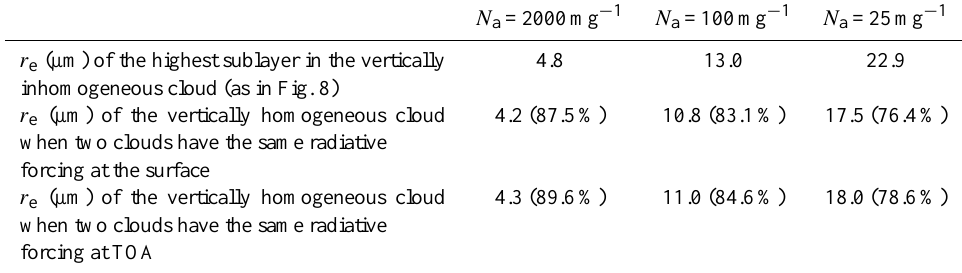
Table 1. Comparison of the r e of the vertically inhomogeneous cloud with that of the vertically homogeneous cloud when two clouds have the same shortwave radiative forcing. Numbers in parentheses represent the ratio of the two. Solar zenith angle is 60 degree. N a =2000mg − 1 N a =100mg − 1 N a =25mg − 1 r e (µm) of the highest sublayer in the vertically inhomogeneous cloud (as in Fig. 8) r e (µm) of the vertically homogeneous cloud when two clouds have the same radiative forcing at the surface r e (µm) of the vertically homogeneous cloud when two clouds have the same radiative forcing at